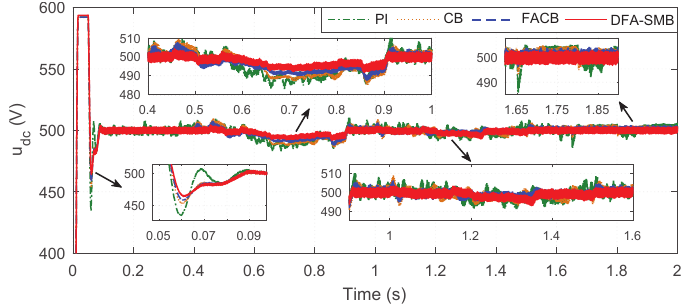
Figure 5. Tracking performance of DC voltage under different controllers.